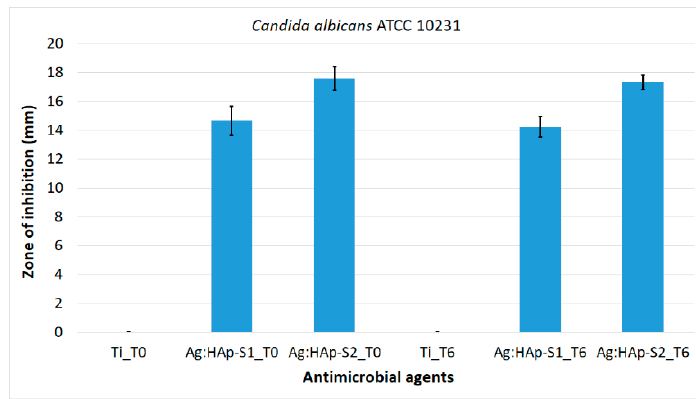
Figure 11. Inhibition zone diameters of Ag:HAp-S1_T0, Ag:HAp-S2_T0, Ag:HAp-S1_T6 and Ag:HAp-S2_T6 composite layers against Candida albicans ATCC 10231 fungal strain.